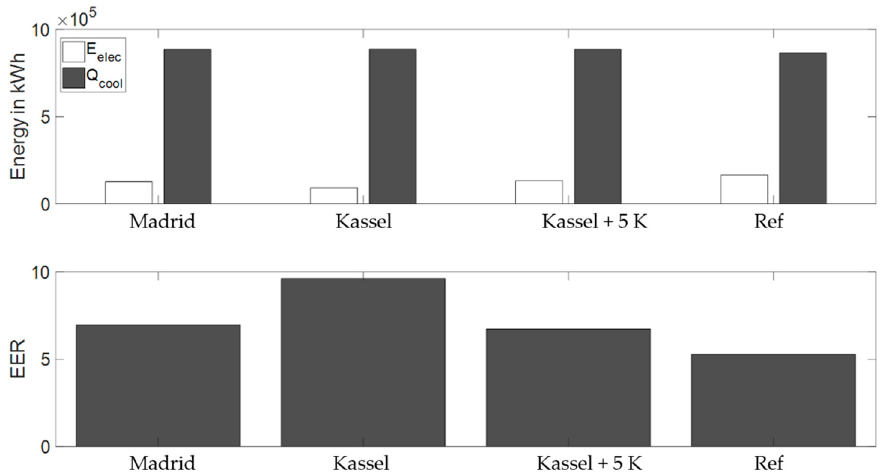
Figure 8. Energy savings and EER comparison for different ambient temperatures .